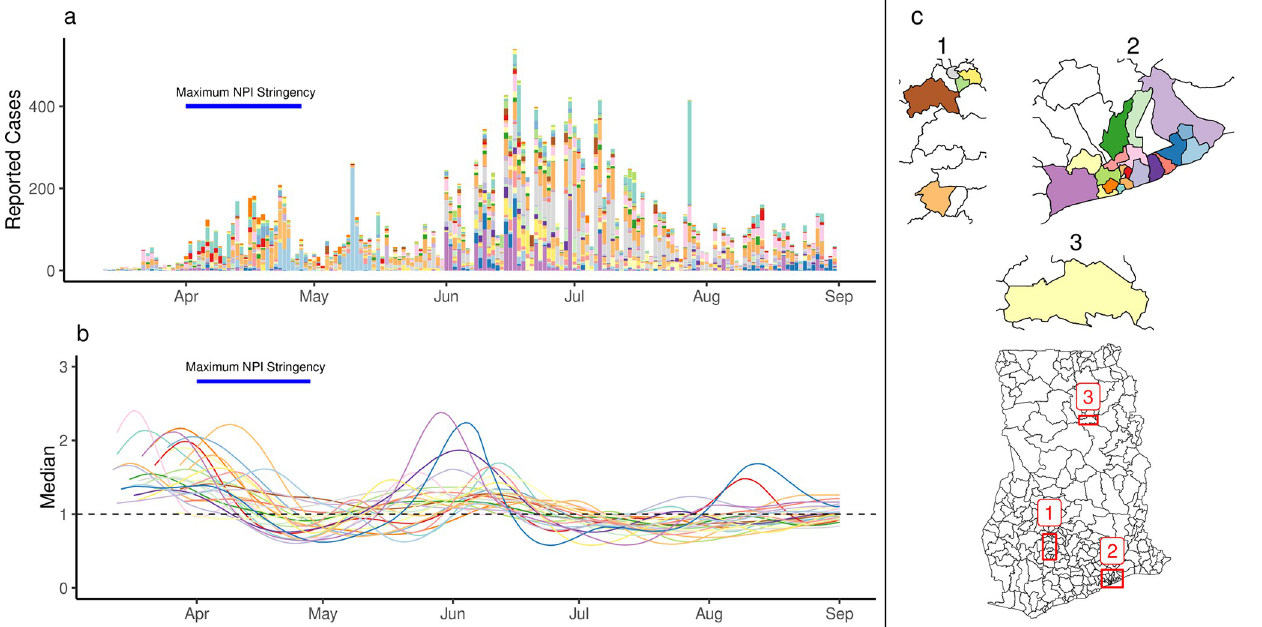
Fig 3. Estimates of R t in individual districts. (a) The number of reported cases in individual districts. (b) Estimates of R t for individual districts (median shown). (c) A map of districts included the analysis. Colors indicate individual districts. Basemap from the Humanitarian Data Exchange with Creative Commons Attribution for Intergovernmental Organisations Licence